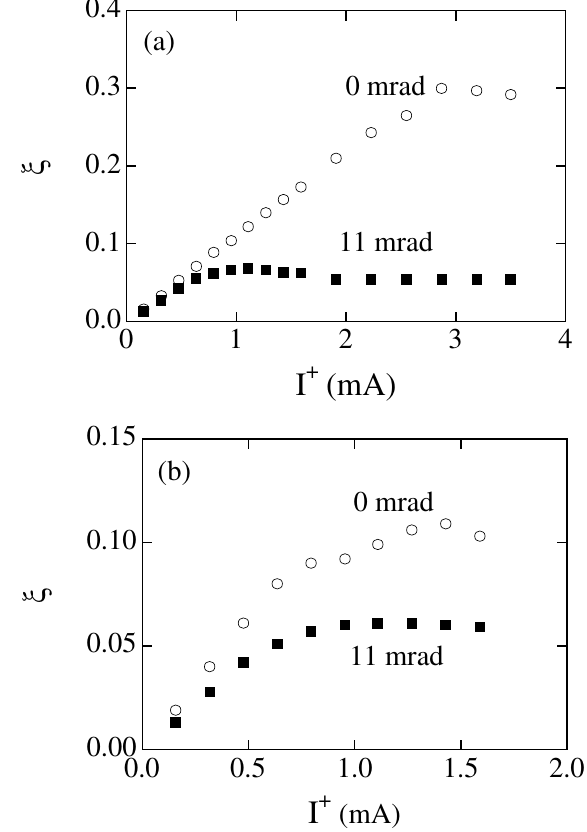
FIG. 3. Beam-beam parameters for crossing angle of 0 and 11 mrad as function of bunch current. (a),(b) were obtained by the weak-strong and strong-strong simulations,